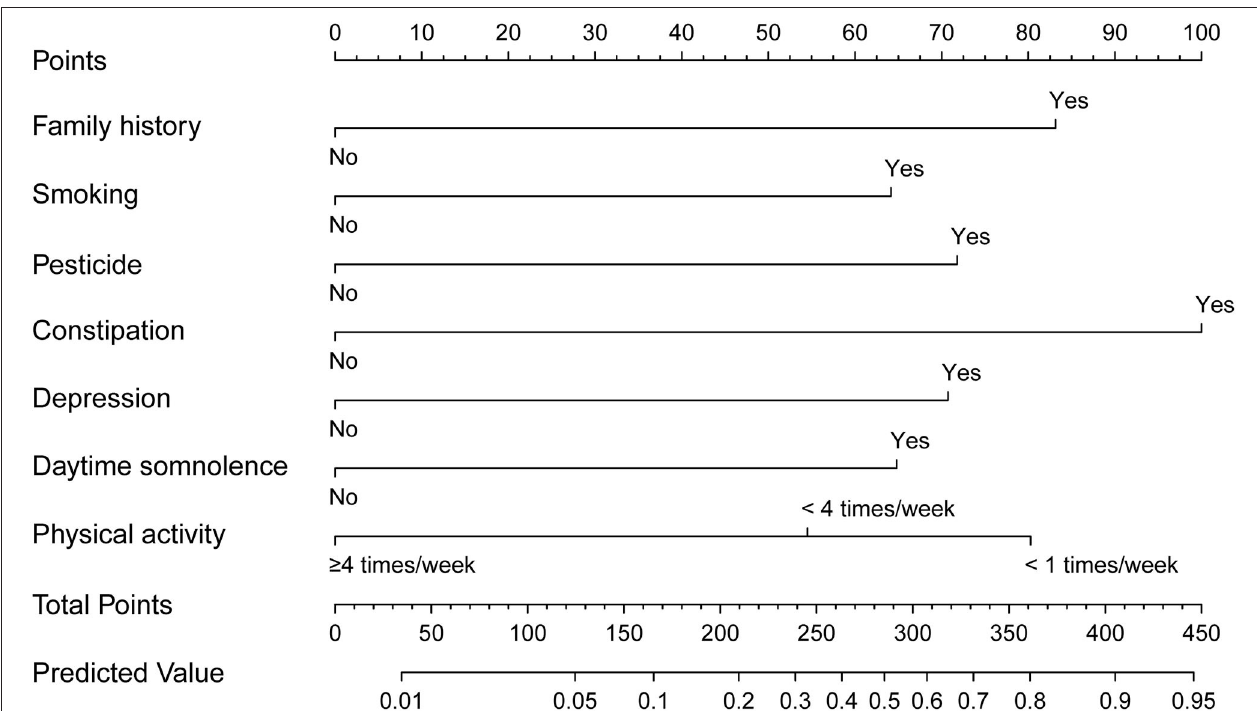
FIGURE 2 | Nomogram to estimate the probability of possible rapid eye movement sleep behavior disorder (pRBD). Find the predictor points on the uppermost point scale that correspond to each subject variable and add them up. The total points projected to the bottom scale indicate the probability of